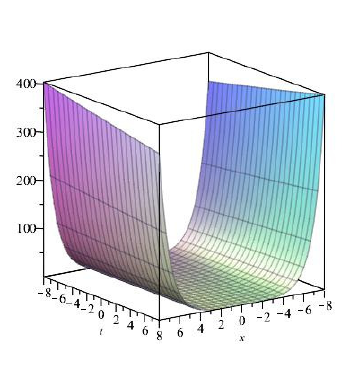
Figure 4. 3D plot of w ( x,t ) of solution (3.14) by considering C 2 = 0, C 3 = − 13, C 4 = 1, (cid:15) = 1 and positive sign for angle. 100